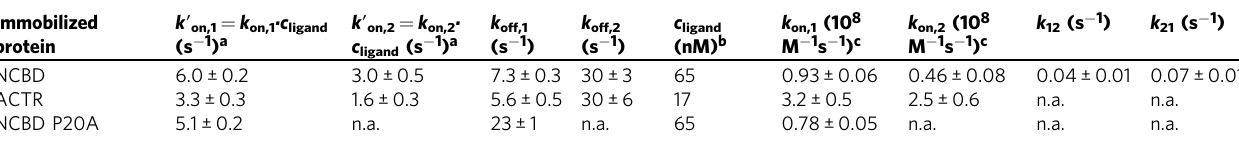
a Pseudo- fi rst-order association rate coef fi cient observed in the time traces. The second-order association rate coef fi cient is calculated based on the ligand concentration c ligand measured by FCS in solution (see Methods) b Concentrations of the acceptor-labeled ligand were determined using FCS (see Methods). An uncertainty of ±5% was estimated from two independent measurements conducted before and after recording the time traces c Second-order association rate coef fi cient calculated from the pseudo- fi rst-order association rate coef fi cient based on the ligand concentration, c ligand , measured by FCS in solution (see Methods). Uncertainty from propagating the error of k ′ on and the ligand concentration. The error for immobilized ACTR is greater owing to the greater uncertainty in the relative populations of NCBD1 and NCBD2, p 1 and p 2 : p 1 = k 21 /( k 12 + k 21 ) and p 2 = k 12 /( k 12 + k 21 ) and 650 ± 150 nM for the low-af fi nity state, NCBD2 (errors are standard deviations based on bootstrapping). The interconversion rates between NCBD1 and NCBD2 are slow ( k 12 = 0.04 ± 0.01 s − 1 and k 21 = 0.07 ± 0.01 s − 1 ) (Table 1), as expected. If direct